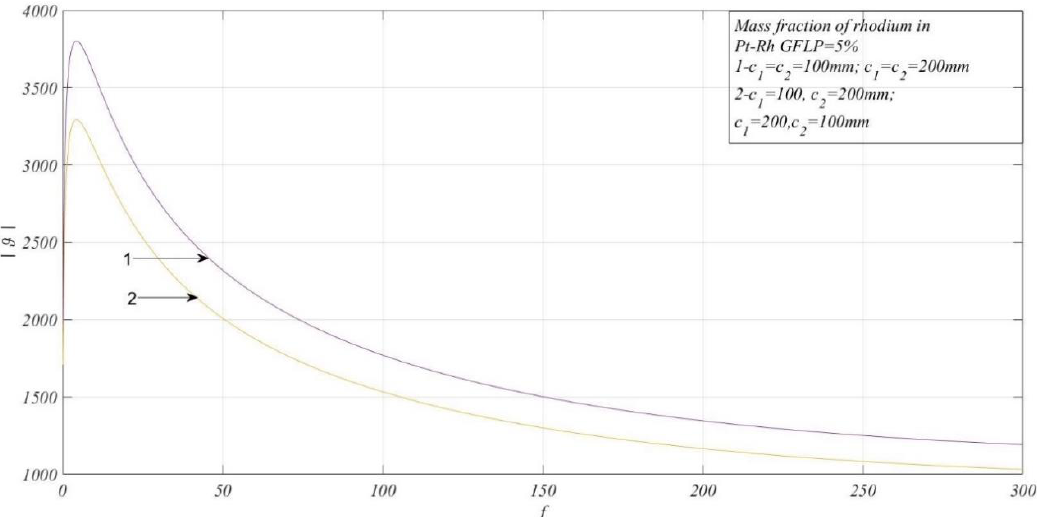
Figure 6. Temperature at the center of the circular opening of the Pt–Rh GFLP.